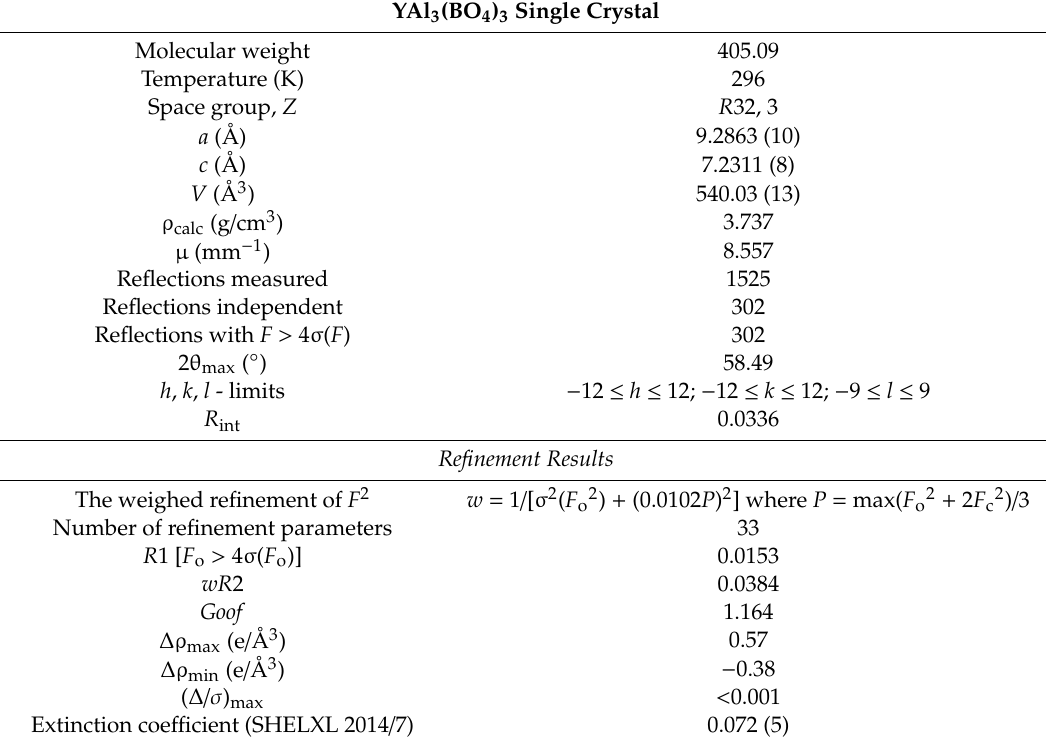
Table 1. Main parameters of processing and refinement of the YAl 3 (BO 3 ) 4 single crystal.